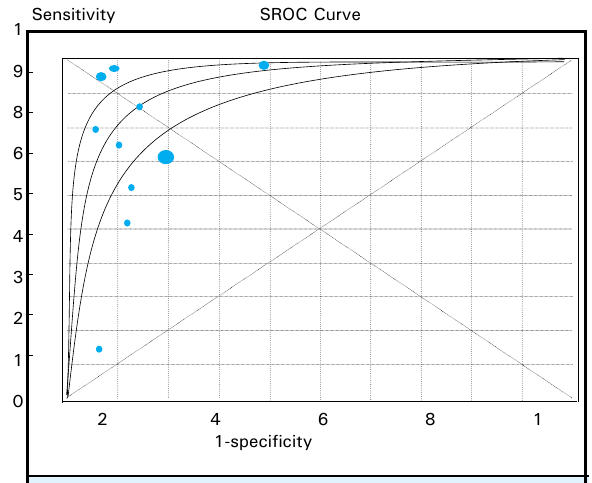
Figure 1. the summary receiver operating curve de- picts the summary receiver operating characteristics for computed tomography. the x-axis represents 1-specificity and the y-axis represents sensitivity. the curve is generated by creating the line which best fits the sensitivity and 1-specificity for each study (circles). tests with an area under the curve closer to 1 are considered to be more